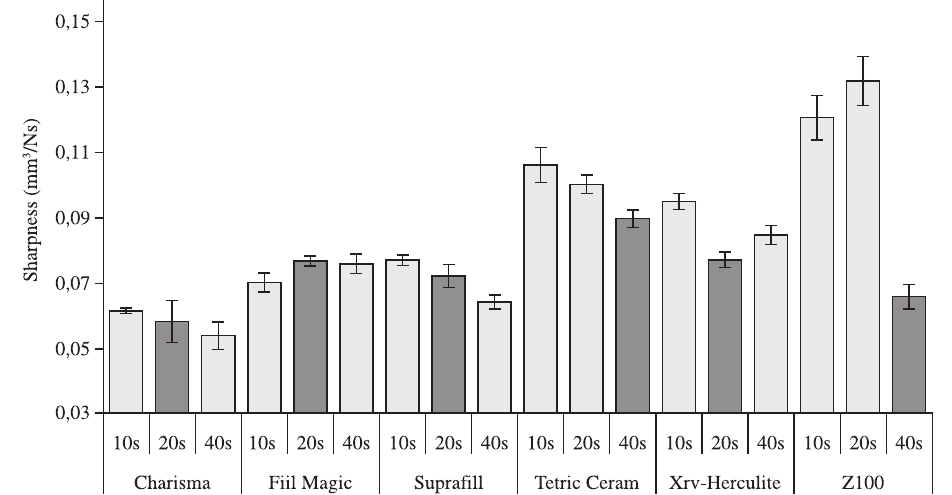
Figure 5. Sharpness results obtained in the assays.